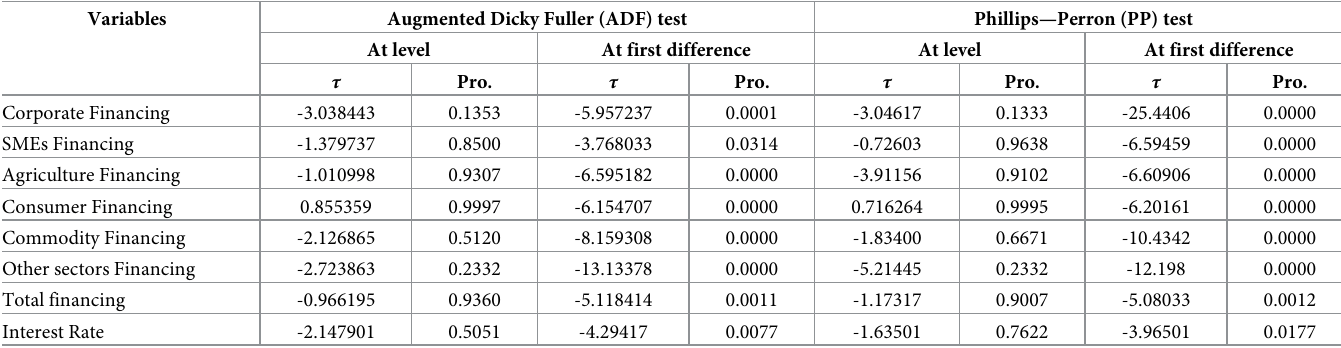
Table 2. Results of unit root test.